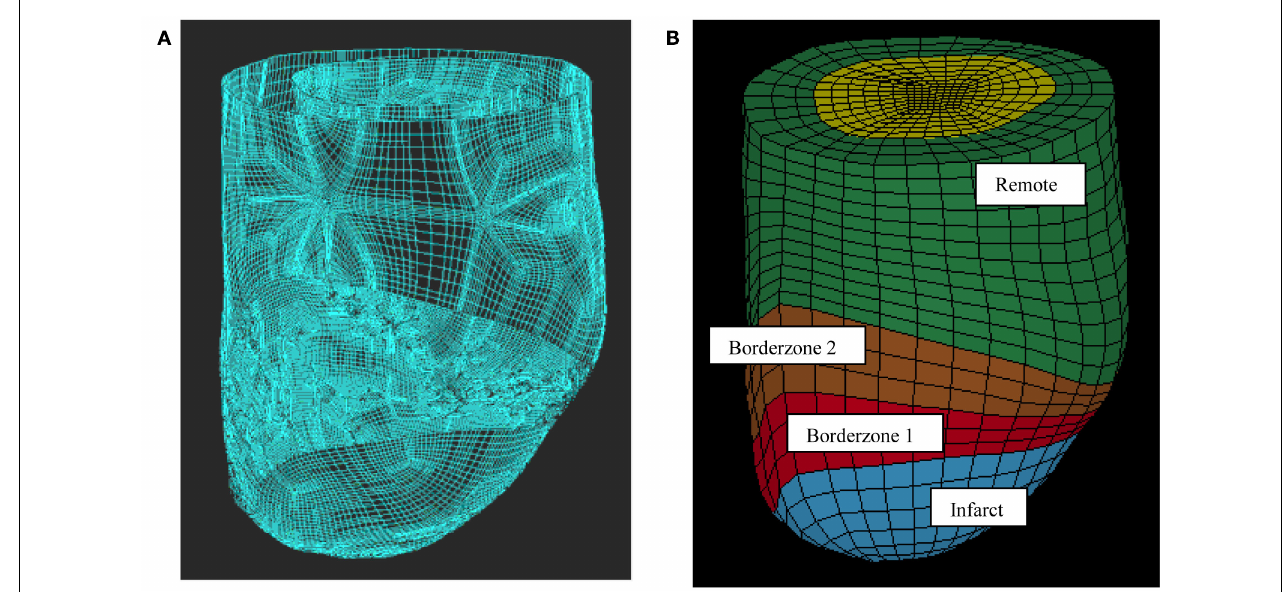
FIGURE 1 | Finite element model of the LV with anteroapical MI. Animal-specific contours were generated from MRI (A) . Solid mesh (B) was broken into four regions (green = remote, brown and red = borderzone, and blue = infarct).